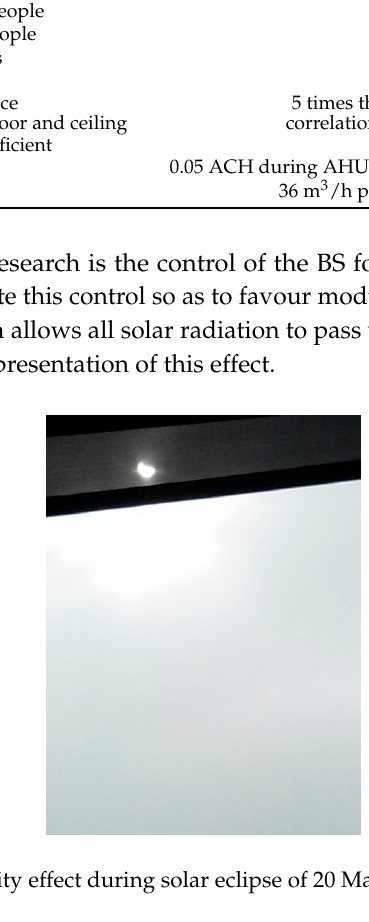
Table 3. Operative parameters of the office module.